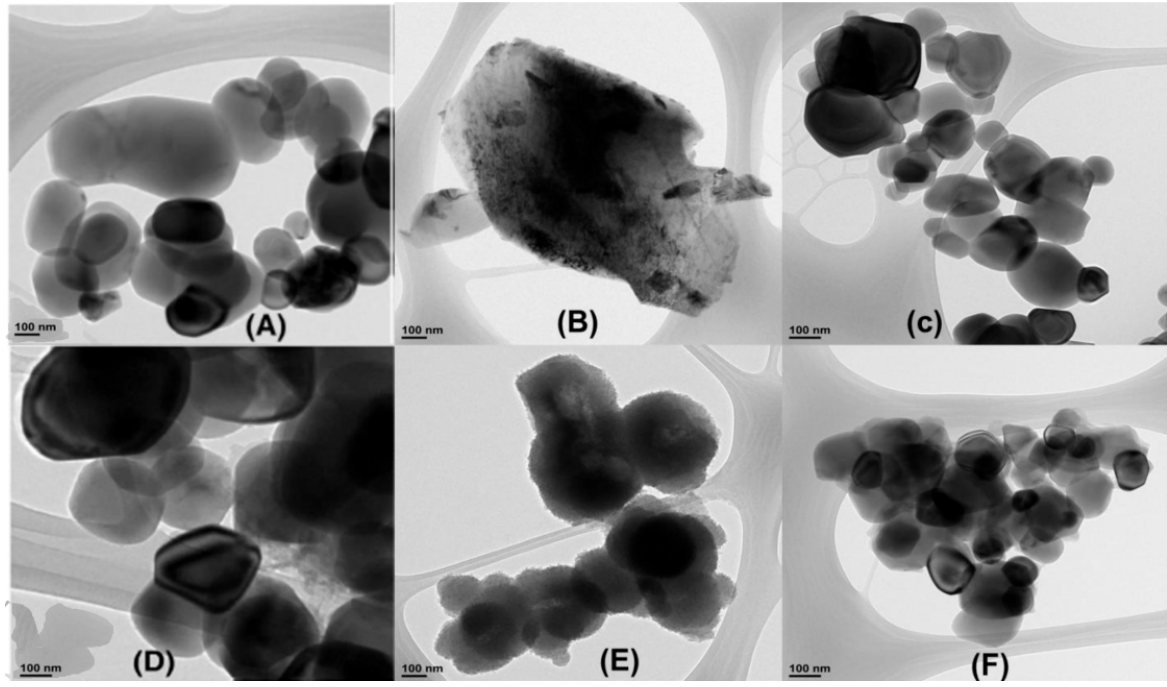
Figure 7. Transmission electron microscopy (TEM) images of ( A ) Al 2 O 3 , ( B ) TiC, ( C ) TiO 2 , ( D ) PANI@Al 2 O 3 , ( E ) PANI@TiC, and ( F ) PANI@TiO 2 .